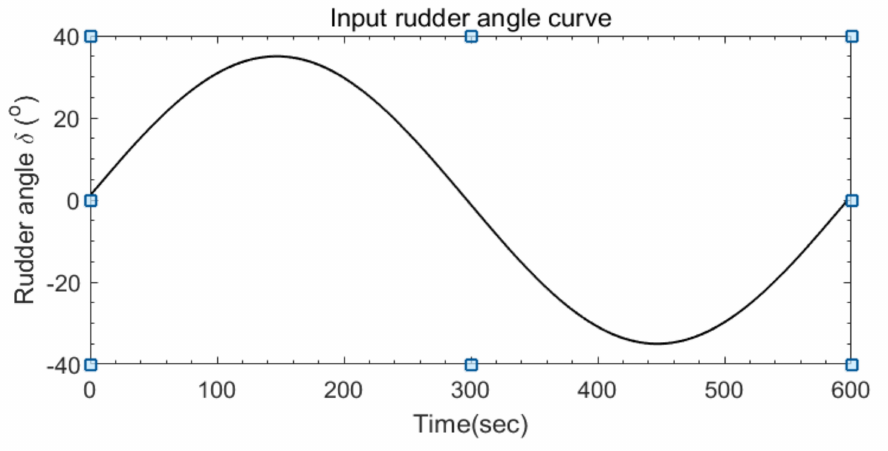
Figure 10. Input samples curve of sine wave.